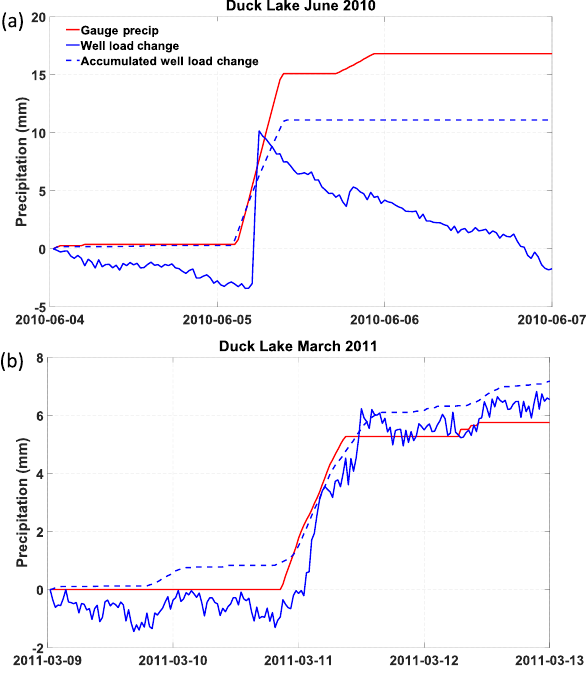
Figure 2. Water-level record for Duck Lake No. 2 observation well (piezometer) compared with the accumulated precipitation from the gauge at the site for the (a) 5–6 June 2010 rainfall event and (b) 11– 12 March 2011 snowfall event. The observation well record has been corrected for the effects of atmospheric pressure changes and earth tides and multiplied by 1.253 to convert the water-level change to an equivalent moisture load change. Time is GMT (LST + 6h). The precipitation data (red solid) have been filtered and accumu- lated, while both unfiltered (blue solid) and filtered and accumulated (blue dashed) well data are shown.